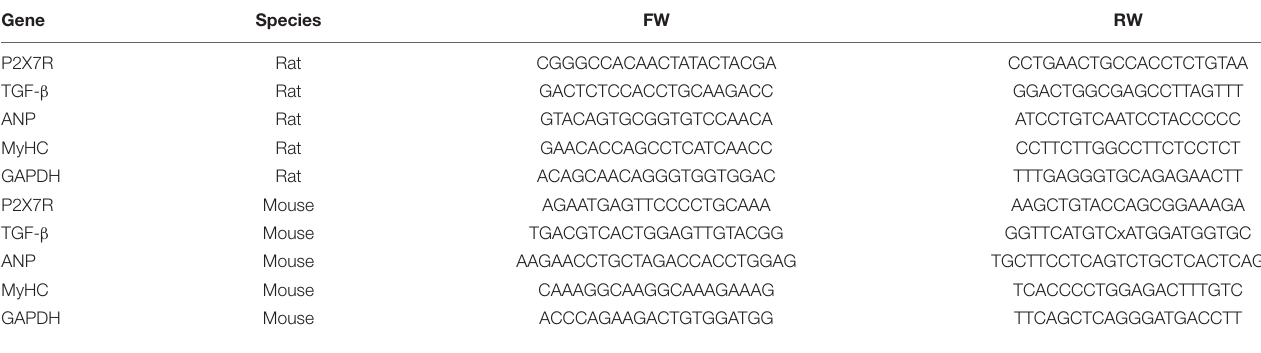
TABLE 1 | The primer sequences of each target